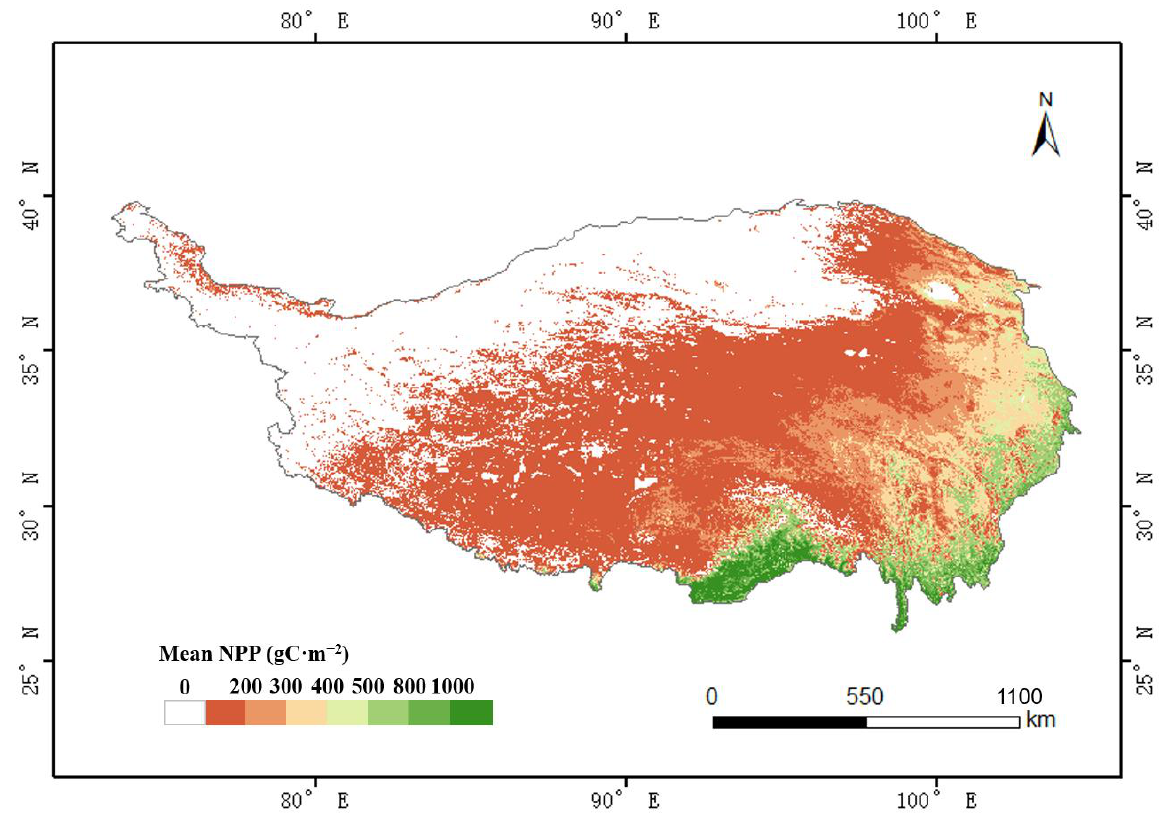
Figure 4. Spatial distribution of annual average of NPP over the QTP from 2001 to 2017. Table 2. The proportion of different ranges of the NPP mean, trend and CV in QTP from 2001 to